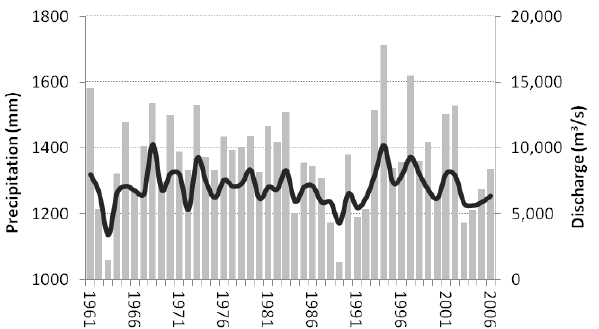
Fig. 2. Annual precipitation (grey bars) in the Xijiang River basin and annual discharge (black line) at Gaoyao hydrological station 1961–2006.